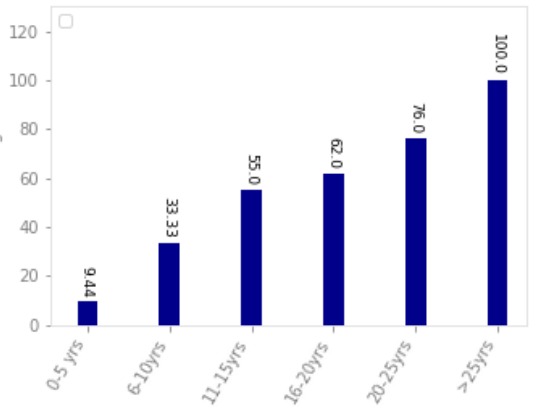
Figure 1. Study of 108 patients shows the prevalence of diabetic retinopathy in the Ophthalmology Clinic at a Tertiary Care Hospital, Telangana State [7].